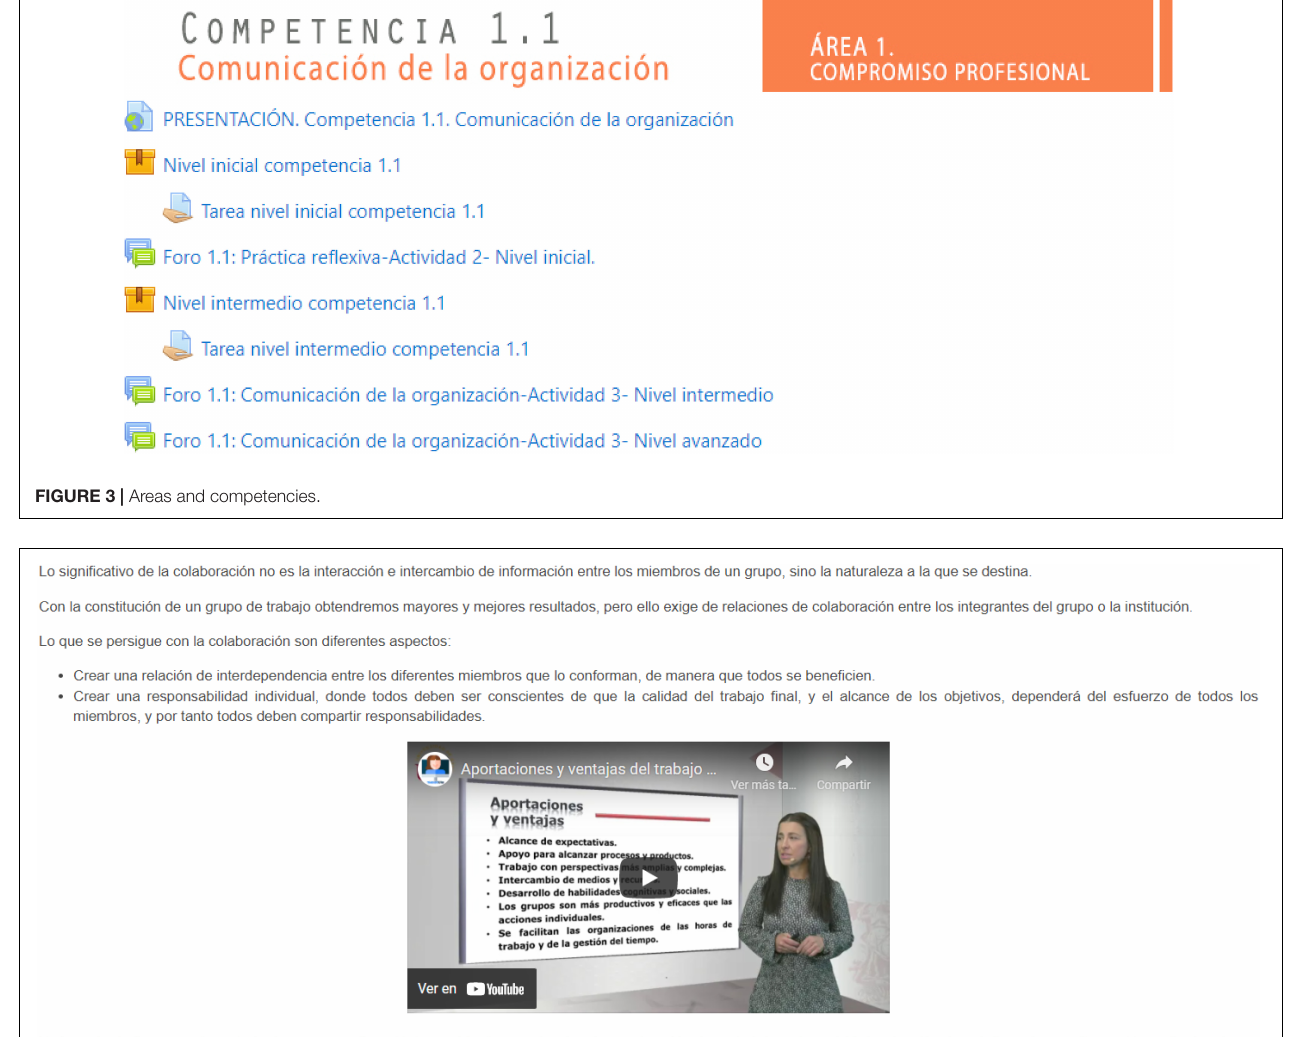
FIGURE 4 | Area and competencies